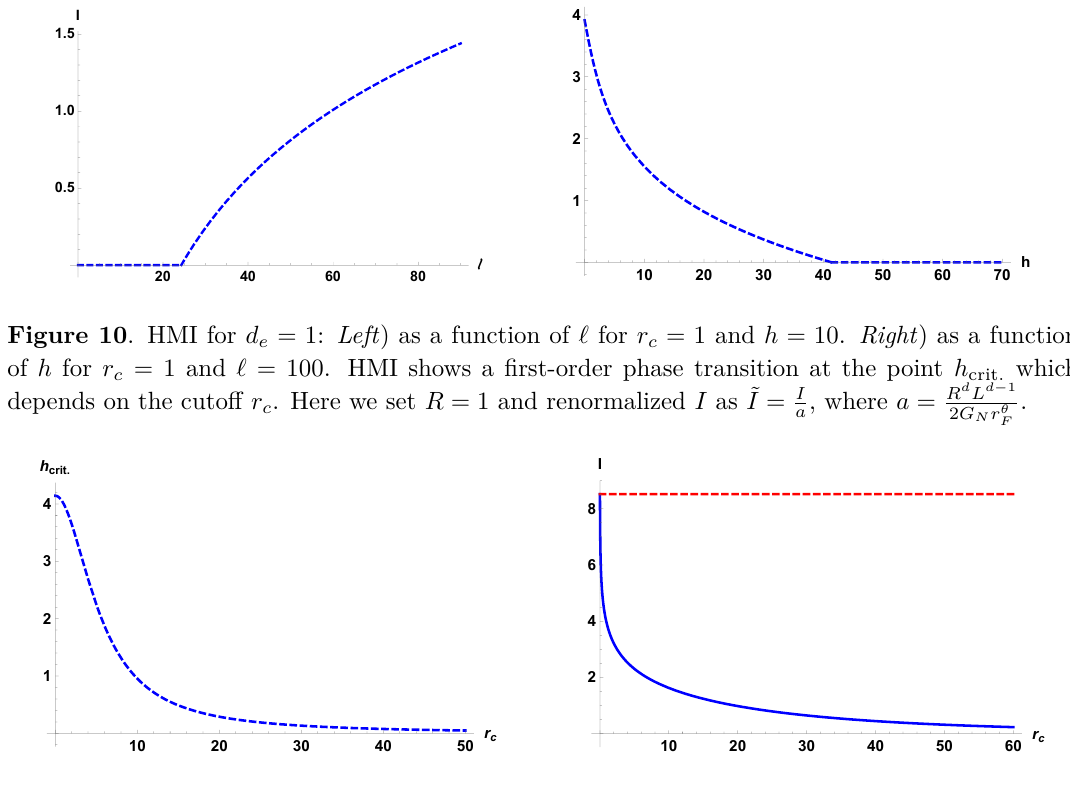
for l = 10 2 , h = 10 − 2 and d = 1 . The c e